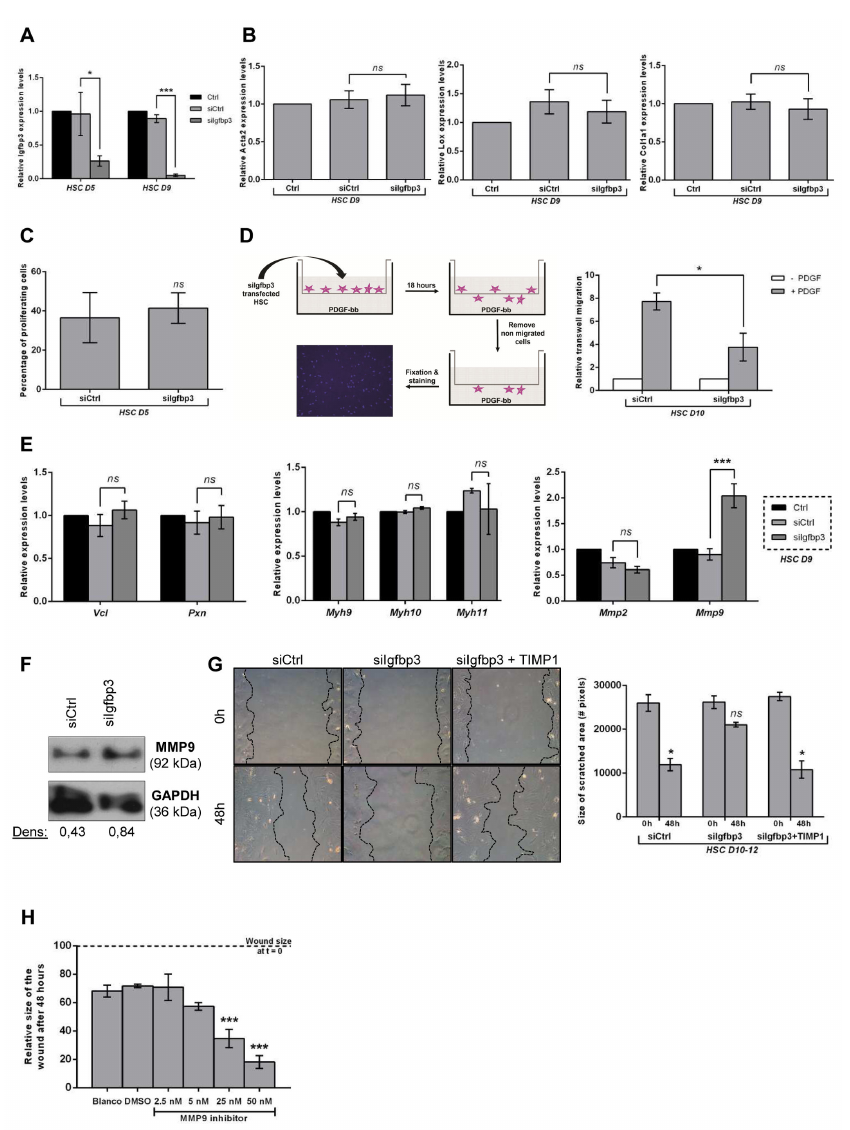
Figure 5. Effect of Igfbp3 knock-down on gene expression, migration and proliferation in activating HSCs (A). mRNA levels of Igfbp3 in activating day 5 HSCs (HSC D5, once transfected at day 1) and day 9 HSCs (HSC D9, twice transfected at day 5/day7) transfected with a control siRNA (siCtrl) or with an siRNA for Igfbp3 (siIgfbp3). ( B ) Acta2 , Lox and Col1a1 mRNA levels in activated day 9 HSCs transfected with siCtrl or with siIgfbp3 ( C ) Influence of Igfbp3 knock-down on the proliferation of hepatic stellate cells (HSCs). At day 2, siIgfbp3-transfected (at day 1) and siCtrl-transfected HSCs were exposed to EdU, fixed 2 days later and stained for DNA-incorporated EdU. The percentage of EdU-positive cells is given. ( D ) Principle of PDGFbb-induced transwell migration (left). siIgfbp3 transfected HSCs were plated at day 9 in transwell inserts. Migration was determined 18 hours (h) later and compared to HSCs transfected with siCtrl. Results are relative to siCtrl/siIgfbp3 transfected HSCs without PDGFbb supplementation (right). ( E ) Vinculin (Vcl), Paxillin (Pxn), myosin heavy chain 9, 10, 11 (Myh9, -10, -11) and matrix metalloproteinase 2, 9 (Mmp2, -9) mRNA levels in activated day 9 HSCs transfected with siCtrl or with siIgfbp3 ( F ) Protein levels for MMP9 and GAPDH on day 9 HSCs transfected twice with siCtrl or siIgfbp3. Densitometry values (dens) for MMP9 relative to the GAPDH loading control are displayed below the Western blot. ( G ) Representative images of HSCs at 0 and 48h after wounding (left), and quantification of migration (right). HSCs were transfected with siCtrl, siIgfbp3 or siIgfbp3 in combination with a supplementation of 100 ng/mL recombinant murine TIMP-1 (siIgfbp3 + TIMP-1). Experiments were repeated at least 3 times. Results in the graphs are expressed as means ± SEM. ( H ) The contribution of MMP9 to HSC migration was evaluated by treatment of activated HSCs with an MMP9 selective inhibitor, using different concentrations, n=2. Migration is expressed as relative to the width of the wound at the start of the scratch. ns = non-significant p ≥ 0.05, * p < 0.05, ** p < 0.01, *** p < 0,001. doi: 10.1371/journal.pone.0084071.g005 PLOS ONE |